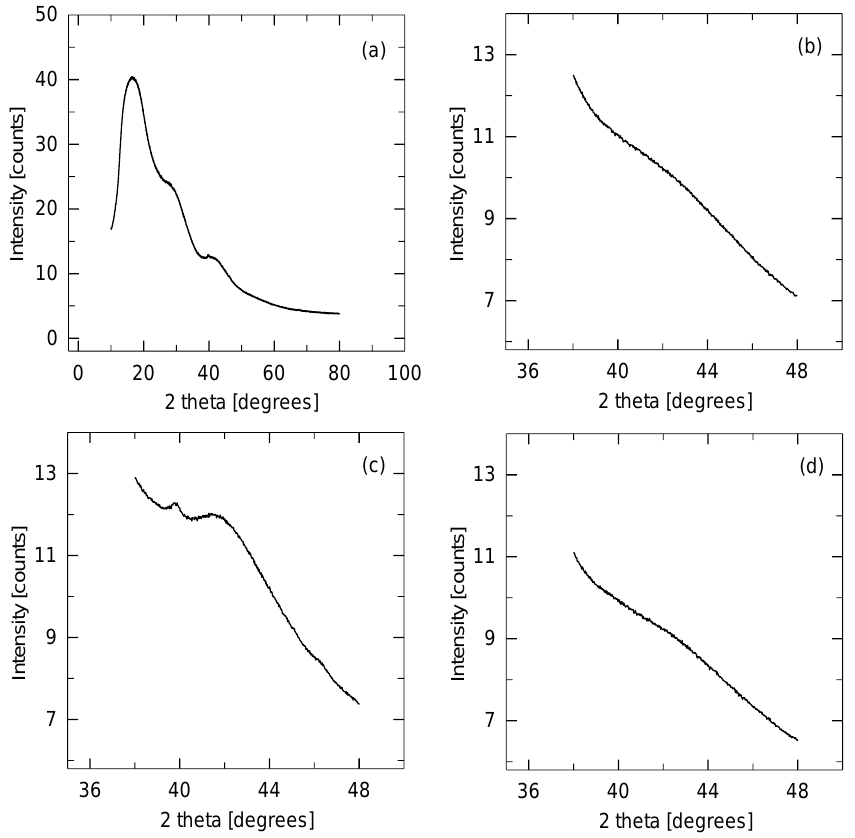
Figure 8. X-ray diffraction patterns of the sample: 0.54 Pt/PBI ( a , c ), 0.08 Pt/PBI ( b ), and 0.68 Pt/PBI ( d ).